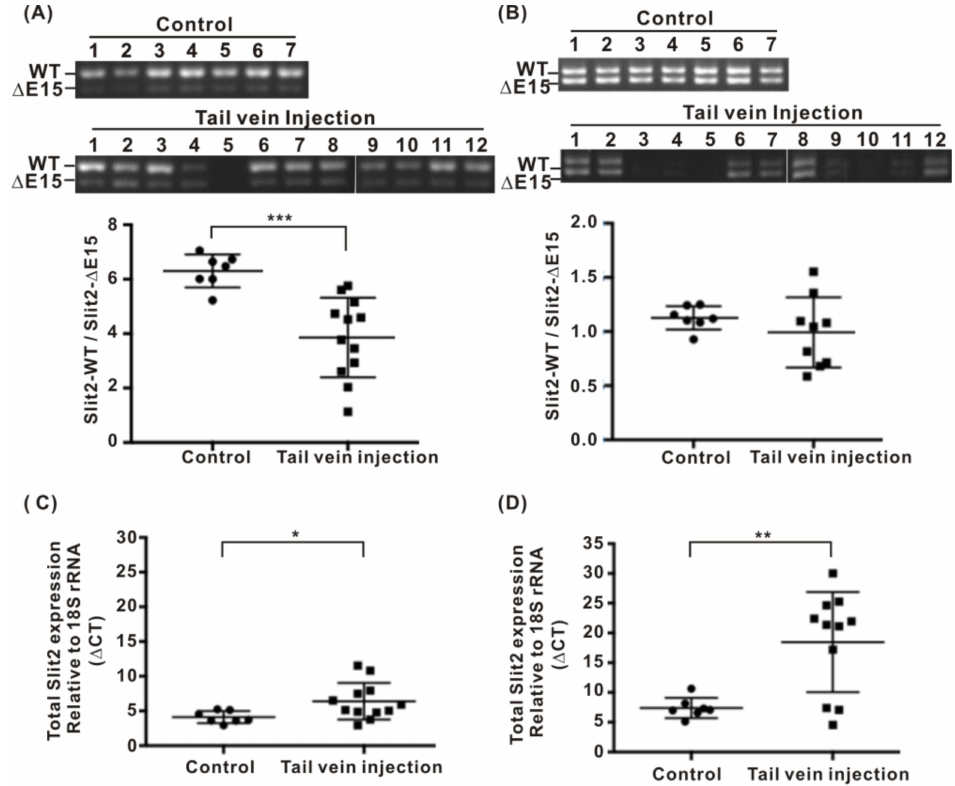
Figure 3. Expression of Slit2-exon15 isoforms in a tail vein injection of lung cancer cells in an animal model. ( A ) Expression of Slit2-exon15 isoforms in the lungs with/without a tail vein injection of lung cancer cells. ( B ) Expression of Slit2-exon15 isoforms in the brain with/without a tail vein injection of lung cancer cells. ( C ) Total expression level of Slit2 in the lungs relative to 18S rRNA. ( D ) Total expression level of Slit2 in the brain relative to 18S rRNA ( ∆ CT = CT slit2 − CT 18SrRNA ; CT: cycle threshold). Higher ∆ CT means a lower expression of Slit2. * p < 0.05, ** p < 0.01, and *** p <